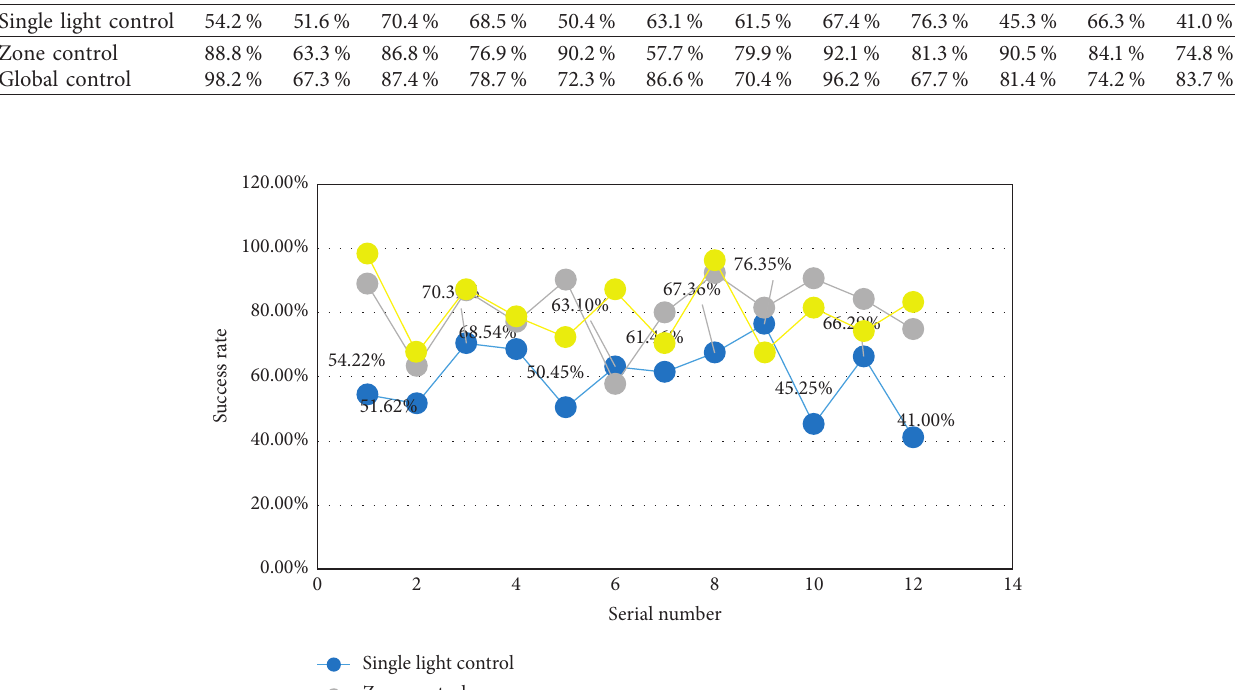
Table 1: Temperature test